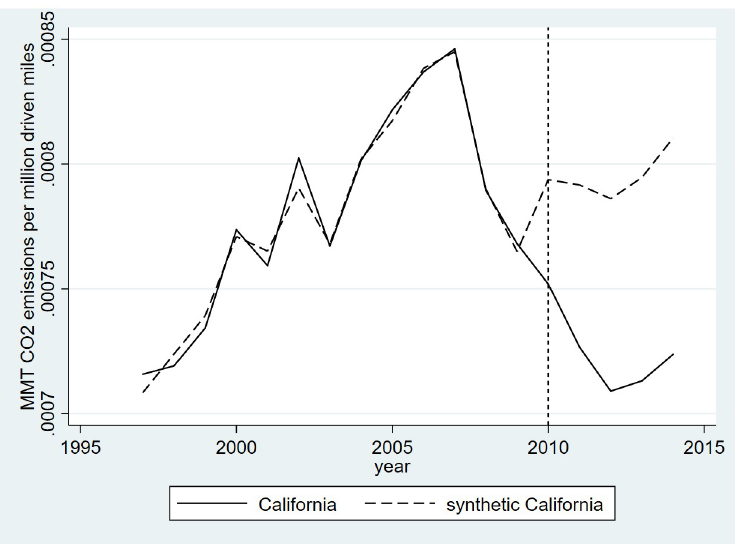
Fig 2. Results of the synthetic control estimation to measure the effect of the LCFS on emissions.